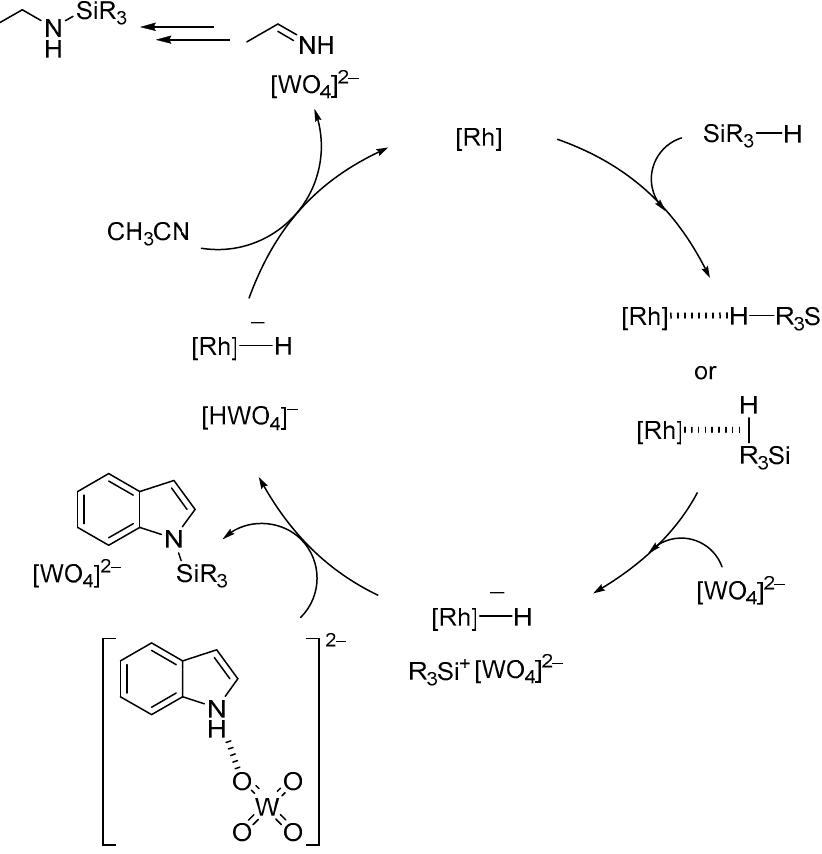
Figure 11. Proposed mechanism for the site-selective N-silylation of indole derivatives with hydrosilanes by combined catalyst of Rh 2 (OAc) 4 and [WO 4 ] 2 − [43].